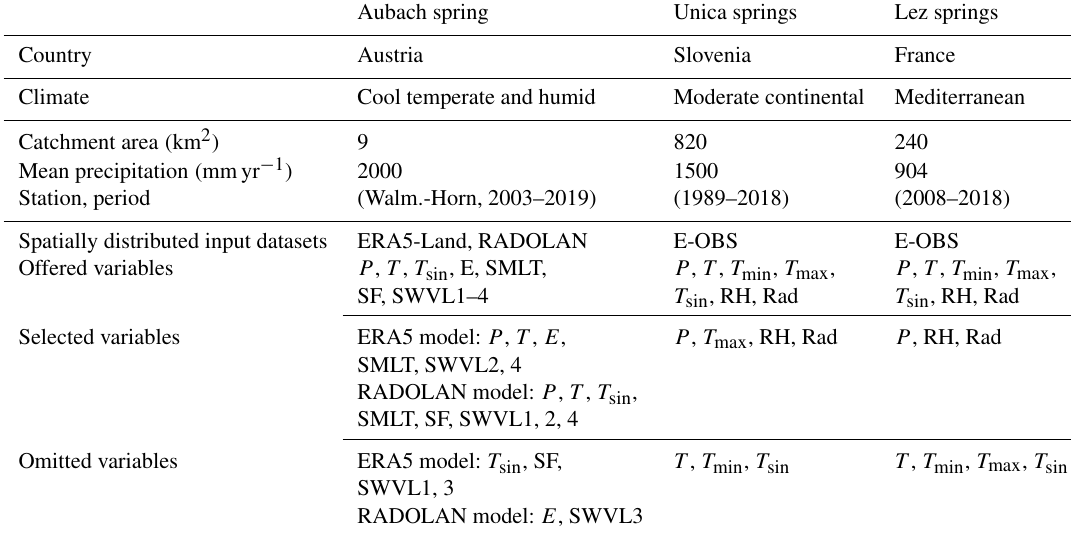
Table A1. Summary and comparison of different aspects of all three study